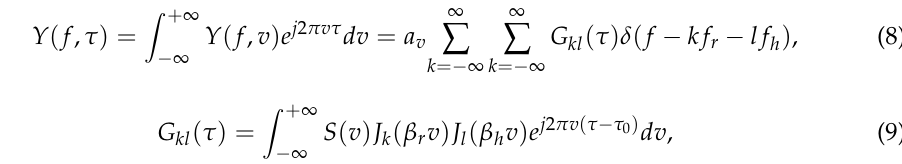
Figure 2. Radar echo preprocessing process.